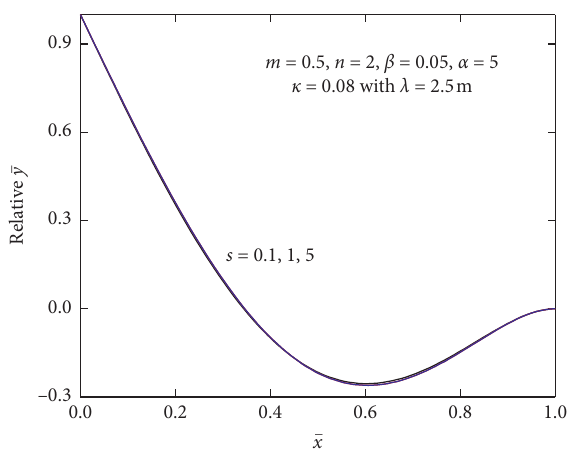
Figure 8: First buckling mode, for different friction ratios s